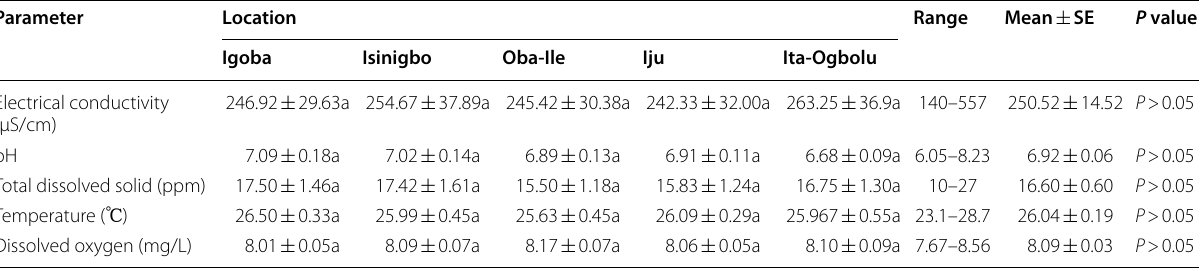
P -values are based on one-way ANOVA test Means followed by the same alphabet (a) in rows are not significantly different ( P > 0.05) from one another using Duncan’s new multiple range test (DNMRT)